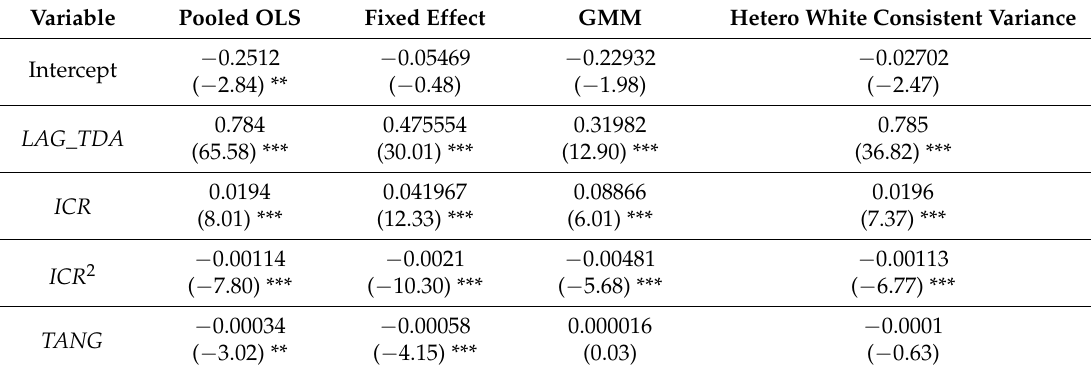
Table 4. Leverage and Credit Rating Scales.